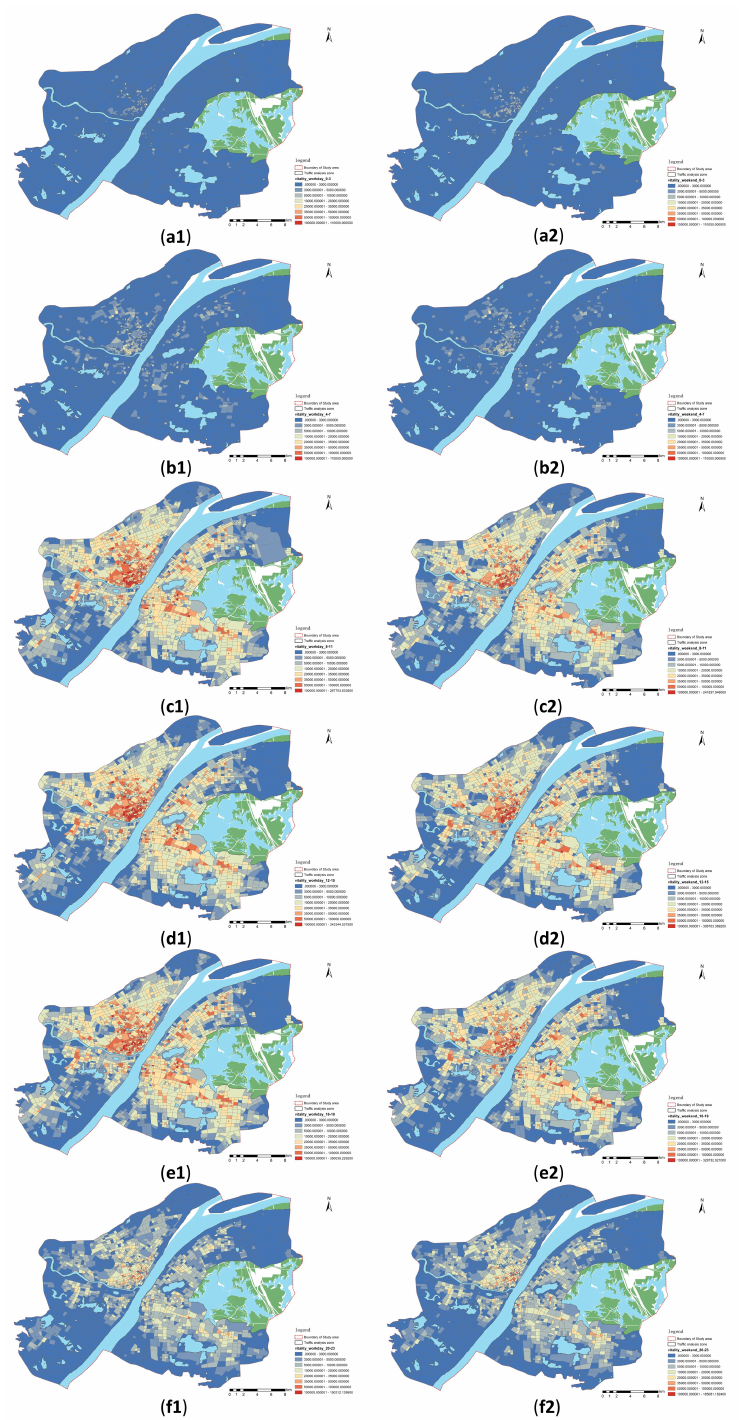
Figure 19. Comparison of block vitality by time period. ( a1 ) Vitality distribution from 0:00 to